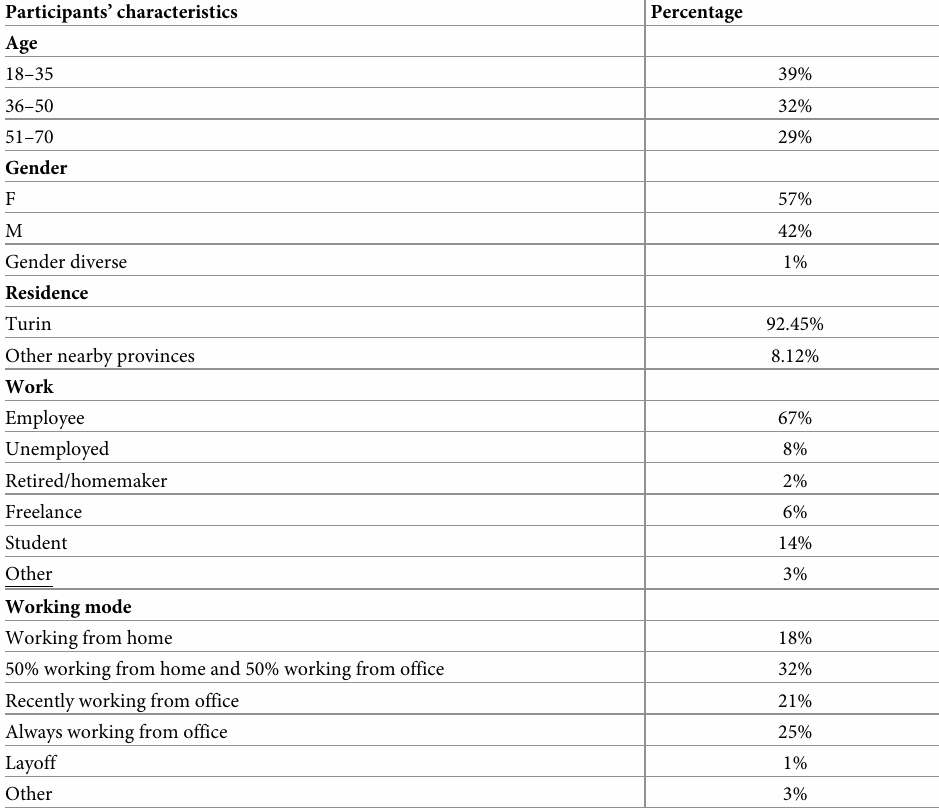
Table 1. Demographic characteristics of the